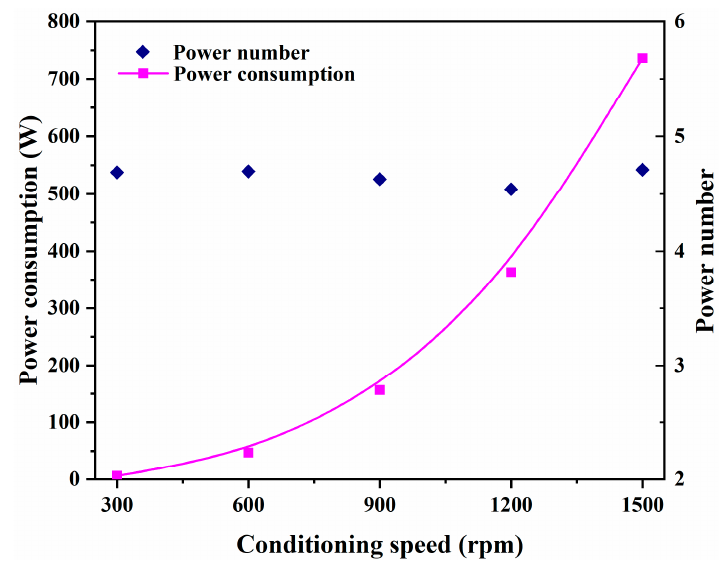
Figure 7. Power consumption and power number under different rotation speeds.